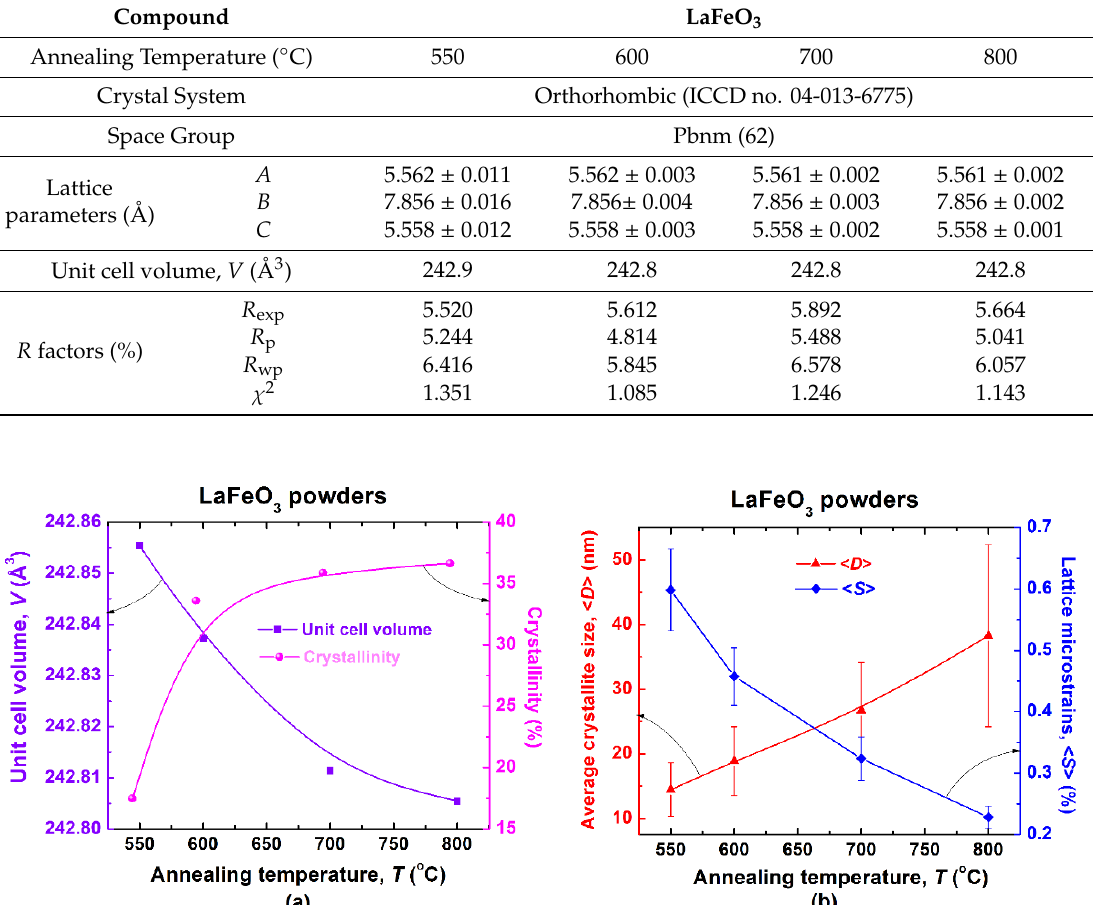
Table 1. Rietveld refined structural parameters for LaFeO 3 powders annealed at various temperatures.